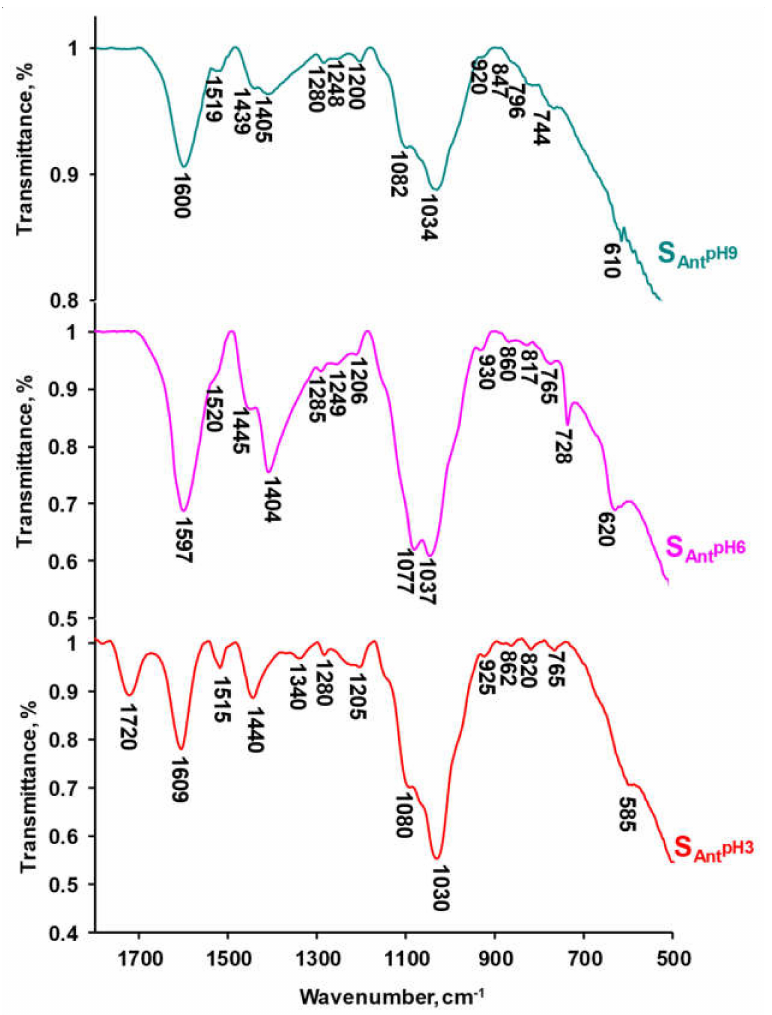
Figure 3. E ff ect of pH on the shape of the attenuated total reflection–Fourier transform infrared (ATR–FTIR) spectra in the anthocyanin fingerprint region (400–1800 cm − 1